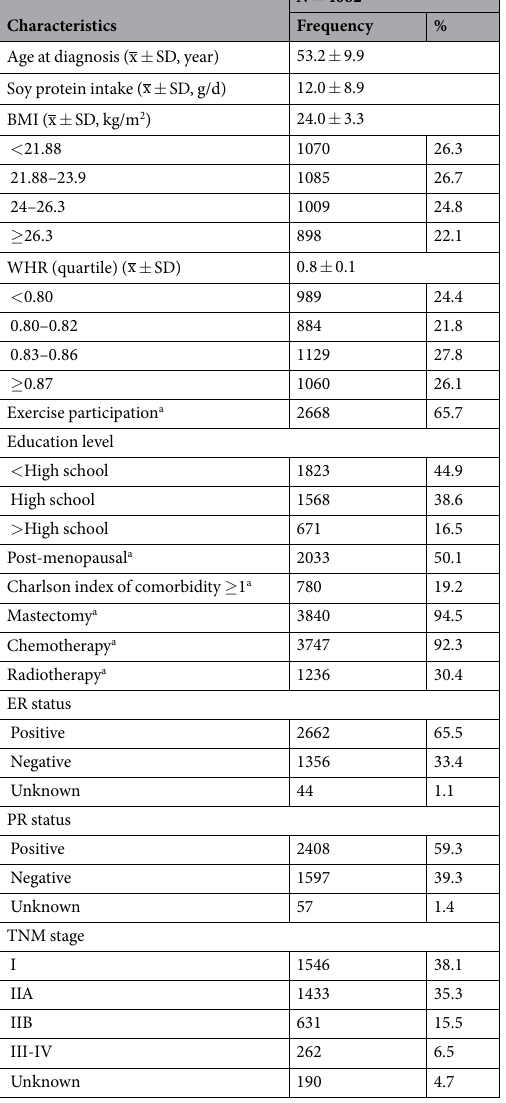
Table 1. Demographic characteristics, clinical and lifestyle factors assessed at the 6 months’ post-diagnosis in 5-year disease-free patients, the Shanghai Breast Cancer Survival Study. a Compared with women who had no corresponding